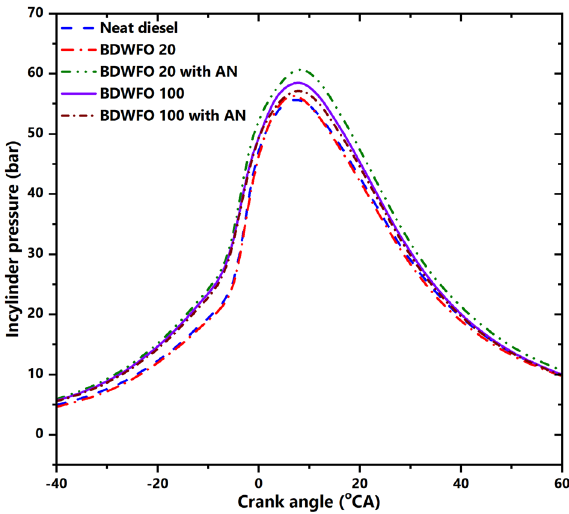
Figure 5. In cylinder pressure (bar) variations related to the crank angle